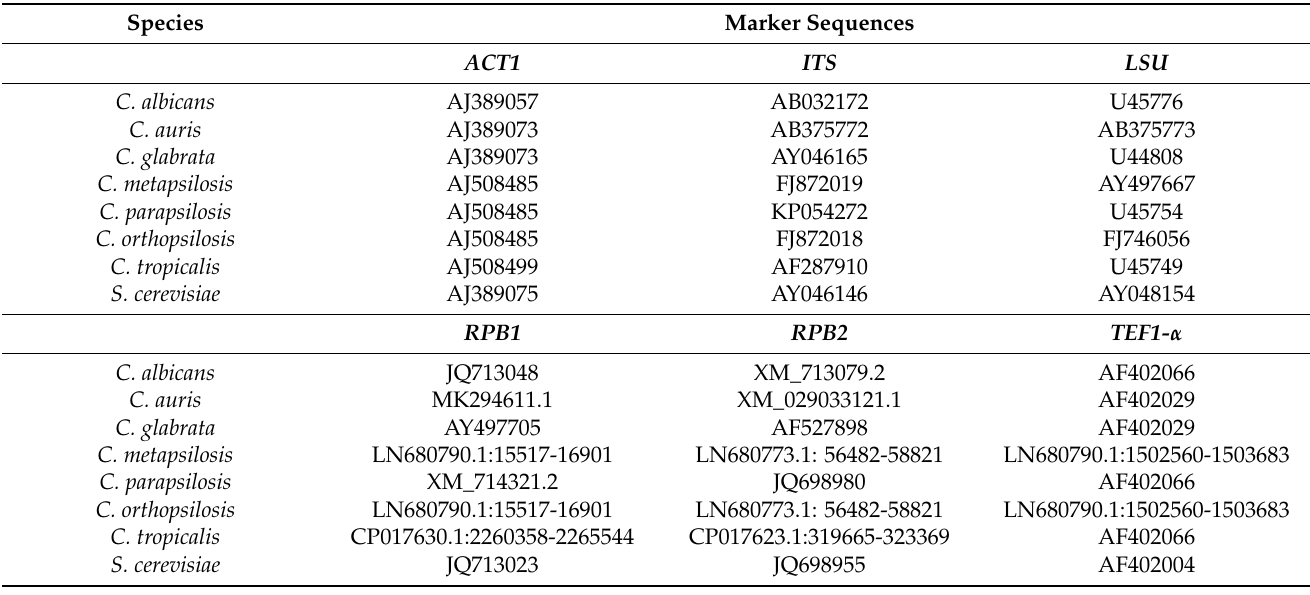
Table 2. List of probe sequences used in the current study. ITS: Internal Transcribed Spacer and LSU: Large ribosomal subunit.